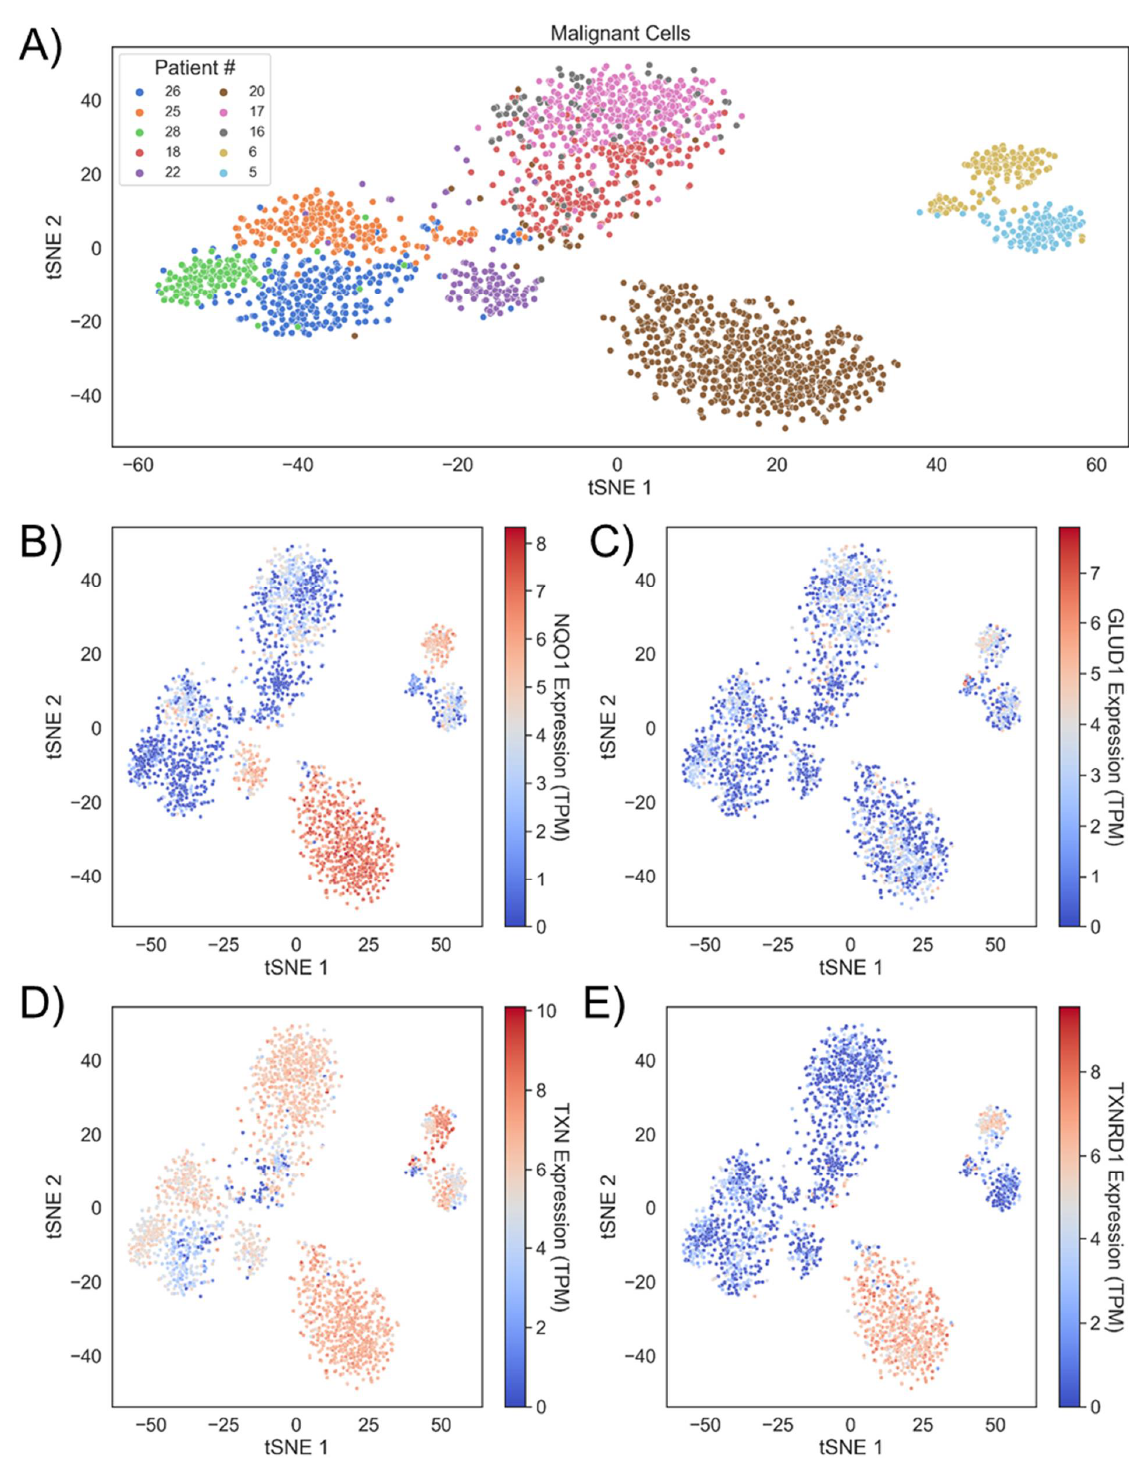
Figure 2. Head and neck cancers demonstrate intratumor and intertumor redox heterogeneity. ( A ) Malignant cells from 10 HNSCC patients cluster together based on redox profiles. Patients are identified by the numbering used in the source data (GEO Accession: GSE103322) ( B ) Clusters colored by NQO1, ( C ) GLUD1, ( D ) TXN, and ( E ) TXNRD1 expression.